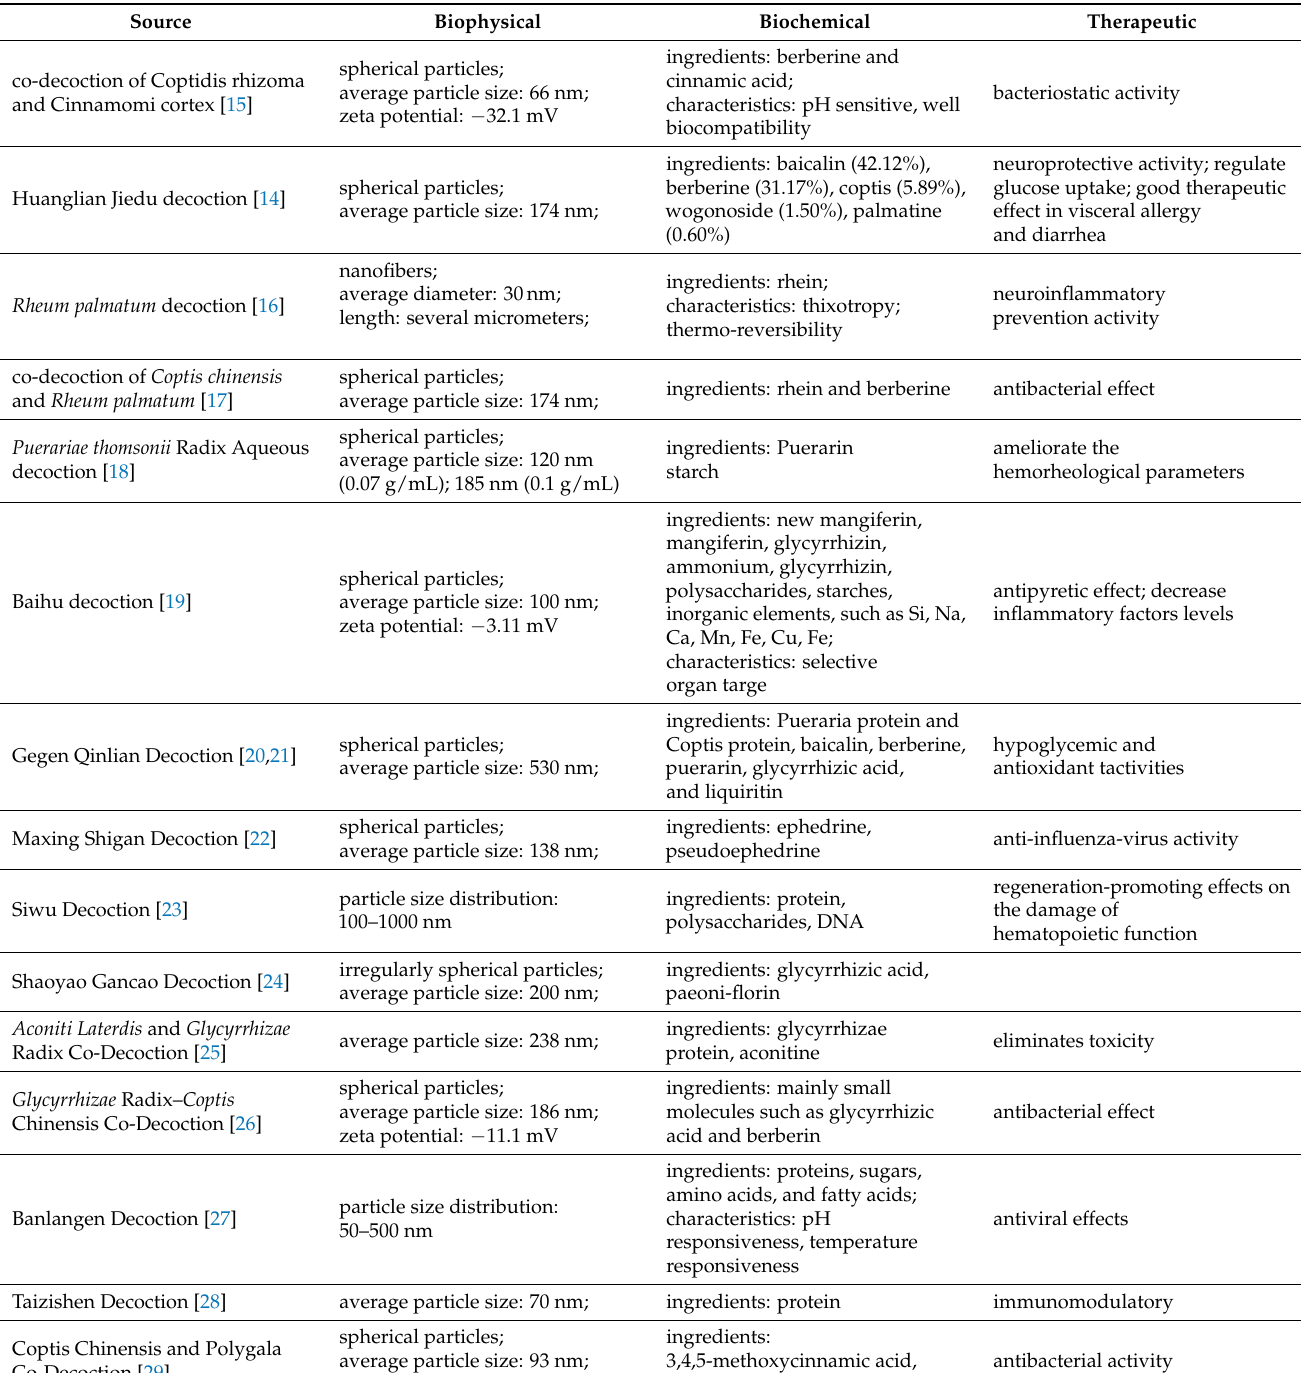
Table 1. Supramolecules in traditional Chinese medicine decoction and their